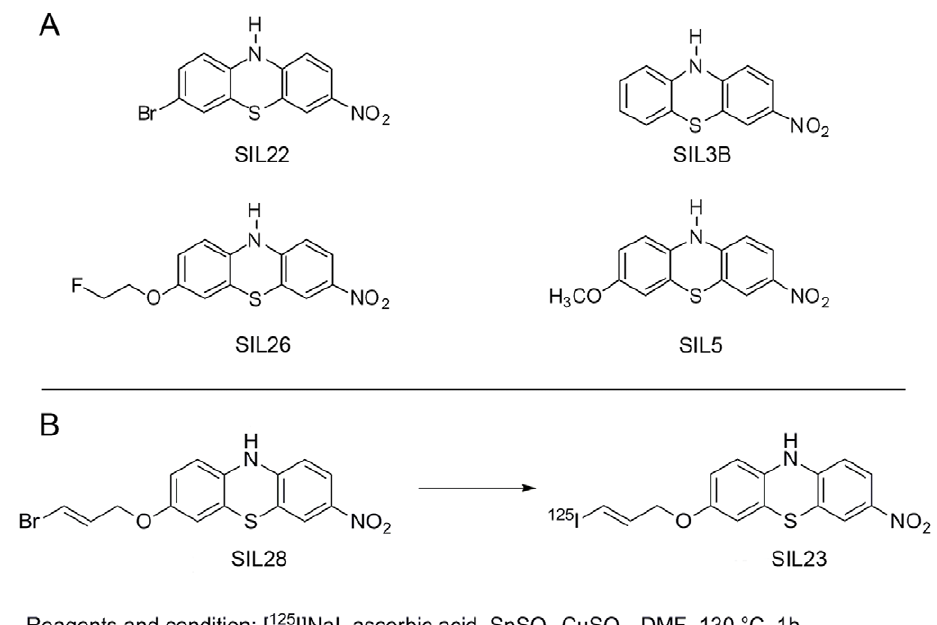
Figure 1. Phenothiazine structures and radiosynthesis of [ 125 I]SIL23. Structures of SIL23 analogues are shown in A . The radiosynthesis of [ 125 I]SIL23 is shown in B . doi:10.1371/journal.pone.0055031.g001 ( Table 1 ). SIL26, which has the highest affinity for a -syn fibrils (K i 15.5nM), has more than 6-fold lower affinity for A b 1–42 (K i 103 nM) and more than 7-fold lower affinity for tau fibrils (K i 125 nM). These results obtained in SIL23 assays with A b 1–42 and tau fibrils indicate that variations in phenothiazine structure can enhance selectivity as well as affinity for a -syn fibrils.